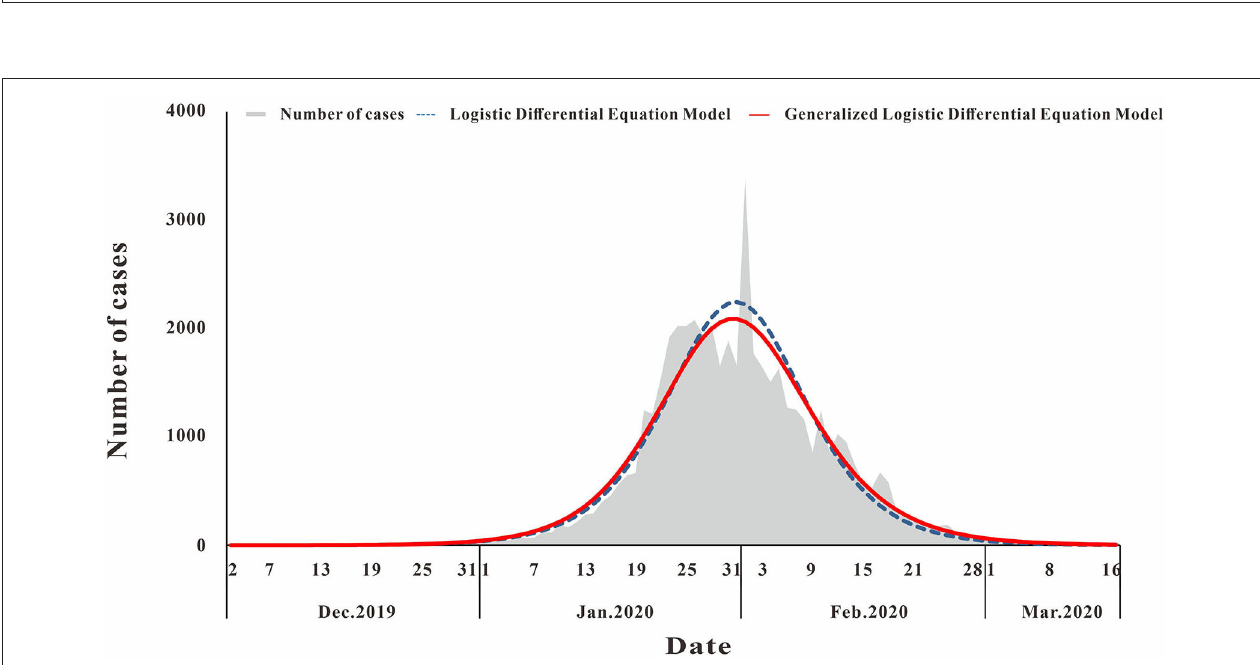
FIGURE 3 | Curve fitting results of logistic and generalized logistic differential equation models of COVID-19.